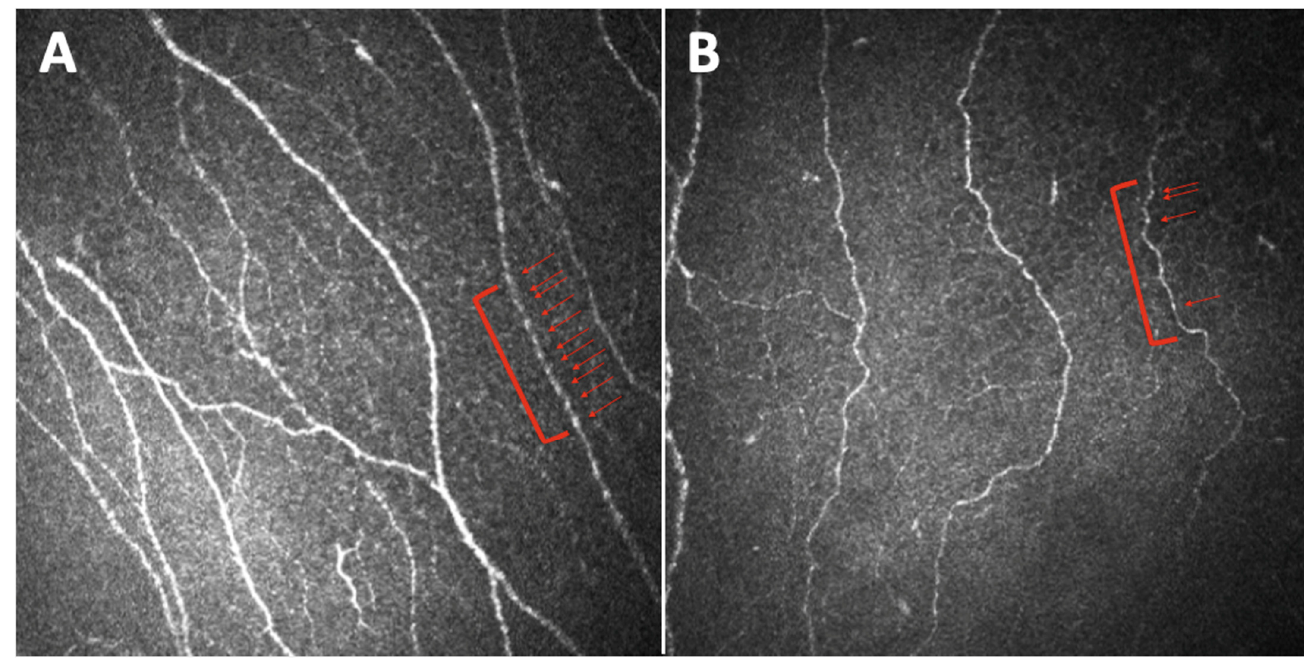
Figure 3. Images of the sub-basal nerve plexus captured with Heidelberg Retina Tomograph III Rostock Corneal Module (Heidelberg, Germany) from the central cornea of a healthy subject ( A ) and a diabetic subject with diabetic peripheral neuropathy ( B ). Red arrows indicate nerve bead- ings, counted in 100 µm of a single nerve fiber (red lines). The comparison highlights how nerve beadings are reduced in diabetic neuropathic patients versus healthy subjects.